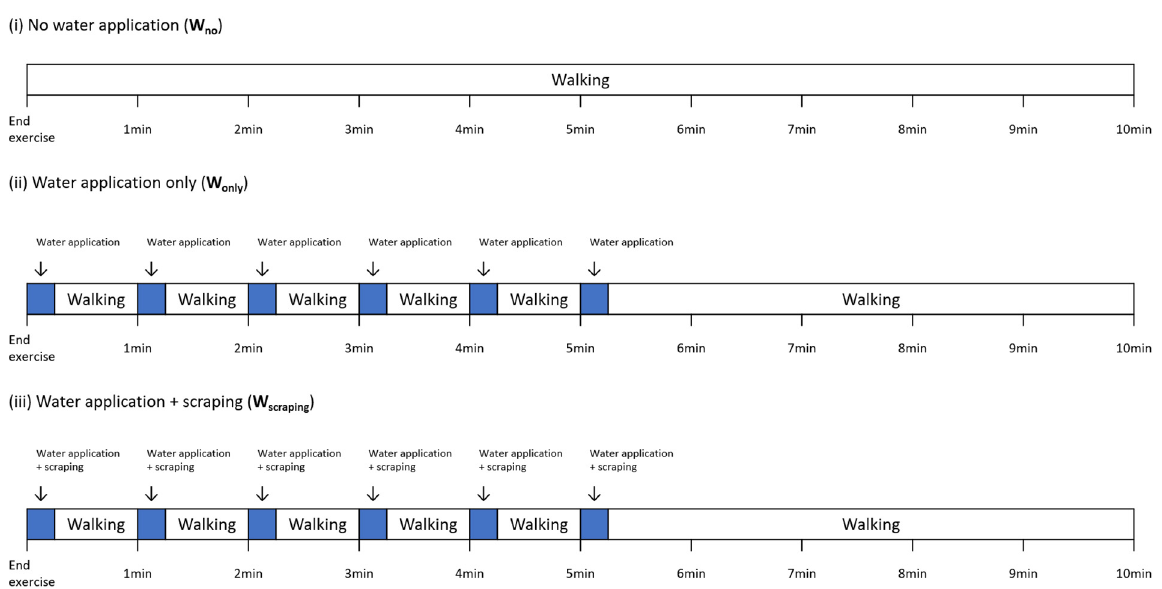
Figure 1. The three cool-down methods applied post treadmill exercise. ( i ) no water application (W no ), ( ii ) water application only (W only ), and ( iii ) water application following scraping (W scraping ). Each cool-down method was applied during the first 10 min post treadmill exercise.